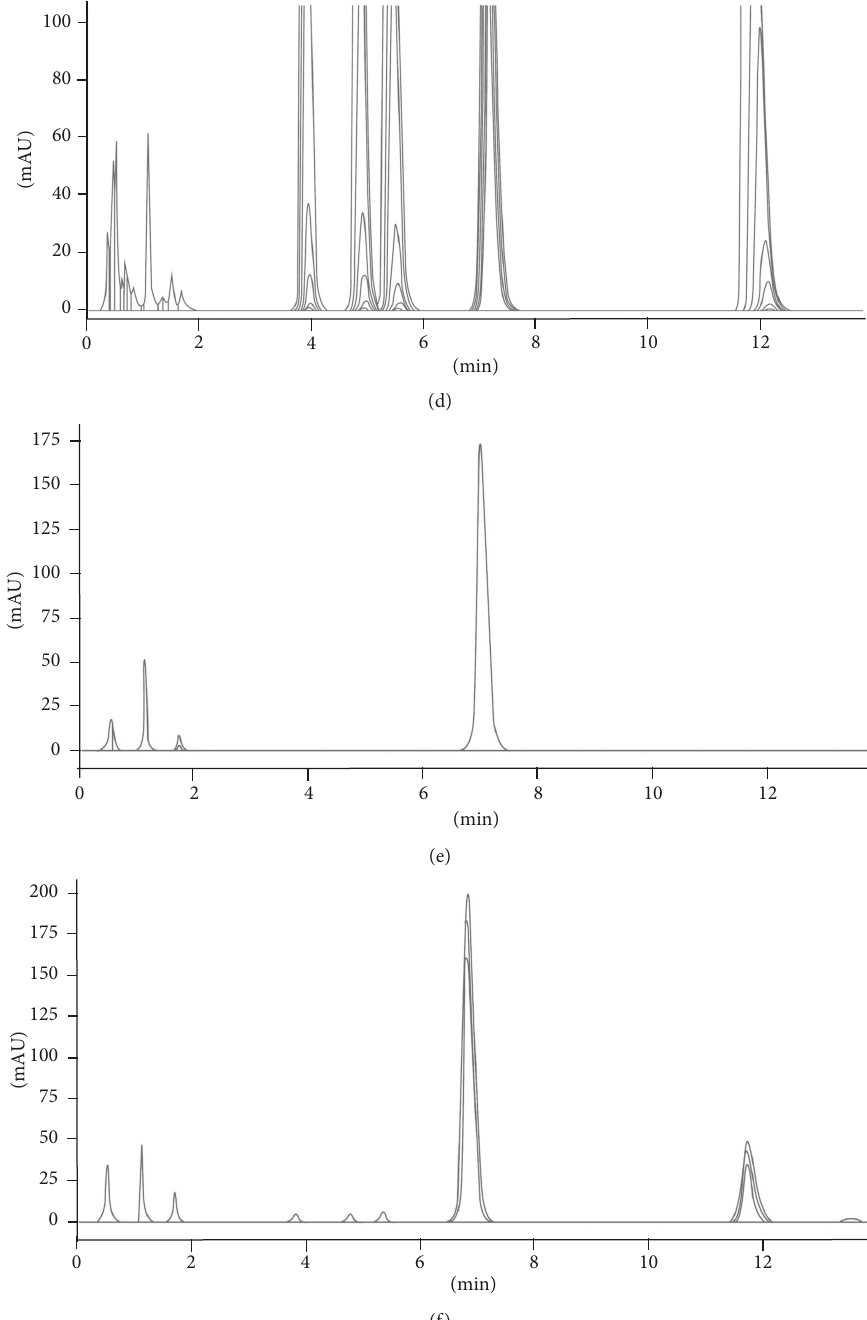
Figure 2: Representative chromatograms of FBS blank (a), FBS + IS (b), FBS spiked with caffeine and metabolites at all calibration curve levels lower (0.1 μ g/mL) and upper (40.0 μ g/mL) (c), and zoomed-in view showing the lower limit of quantification (d); plasma obtained from a mother volunteer and her child (e) without caffeine and metabolites (volunteer 3); and plasma obtained from a mother volunteer and a pair of her twins T1 and T2 (e) containing caffeine and metabolites (volunteer 5). Theb: theobromine (RT 3.8 min), Par: paraxanthine (RT 4.8 min), Theo: theophylline (RT 5.5 min), IS: 7- β -(hydroxyethyl)theophylline (RT 7.0 min), and caffeine (RT 12 min). RT: retention